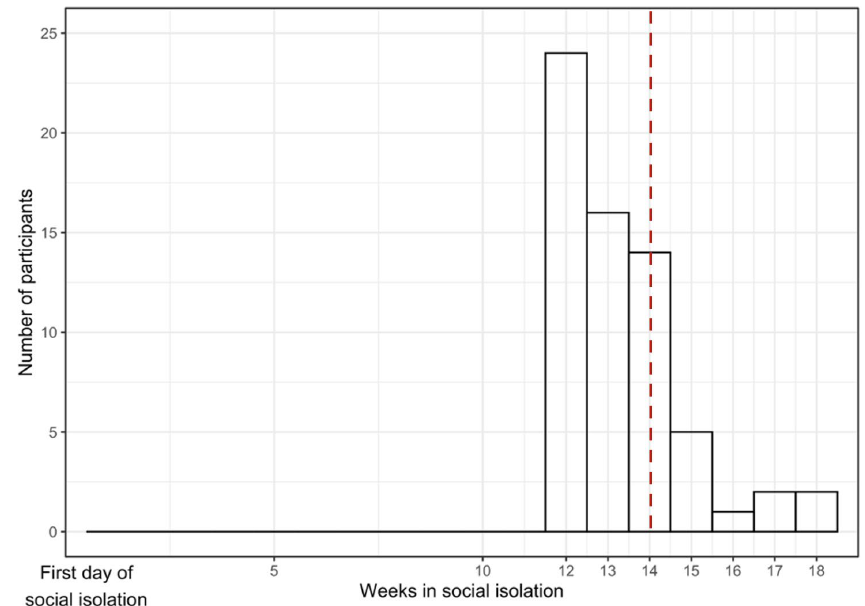
Figure 1. Time elapsed in social isolation. In total, 65 participants answered the questionnaire (axis y ). The amount of time spent in isolation (axis x ) was calculated as the number of weeks elapsed between the start of social isolation (3 September 2020) and the administration of the follow-up ASR. The red dashed line indicates the median (14 weeks). We categorized this variable as low (<14 weeks in social isolation) and high ( ≥ 14 weeks in social isolation) based on the median weeks spent in social isolation prior to assessment. We used the sign test, a non-parametric test to assess differences between paired ob- servations, to assess the difference between YSR/ASR symptoms before and after social isolation. The choice of the sign test was also driven by the non-symmetric distribution of differences. We then examined how the amount of time in social isolation, defined as the time elapsed between the first day of social restrictions and the follow-up visit, impacted differences in YSR/ASR scores. We applied a linear regression model to examine how time elapsed in isolation (independent variable) predicted the change in YSR/ASR scores, ad- justing for age, sex, baseline SES and IQ. We then determined whether the associations between time in social isolation and the change in ASR scores differed by sex through a multiplicative interaction term. Statistical significance level was set at 5% for all tests. All the statistical analyses were performed with R (version 4.1.0). 3. Results 3.1. Sociodemographic Characteristics Sociodemographic characteristics of PHIME participants included in this study are presented in Table 1. In total, 65 participants (26 male, 19.8 +/− 2.4 years) repeated the ASR during or following the social isolation (i.e., follow-up). Participants experienced an aver- age of 14.6 +/− 9.5 weeks with social restrictions before completing the follow -up ASR questionnaire (Figure 1). The average IQ was 106.1 (SD 9.7). No YSR/ASR scores indicated problematic behaviors at baseline or follow-up (Supplementary Table S1). Sociodemo- graphic characteristics and baseline ASR scores of those participants who completed the online follow-up assessment did not differ from those who did not complete the assess- ment. The amount of time (weeks) spent in social isolation ranged from 12–18 weeks, the average time spent in isolation was 14 weeks (Figure 1).